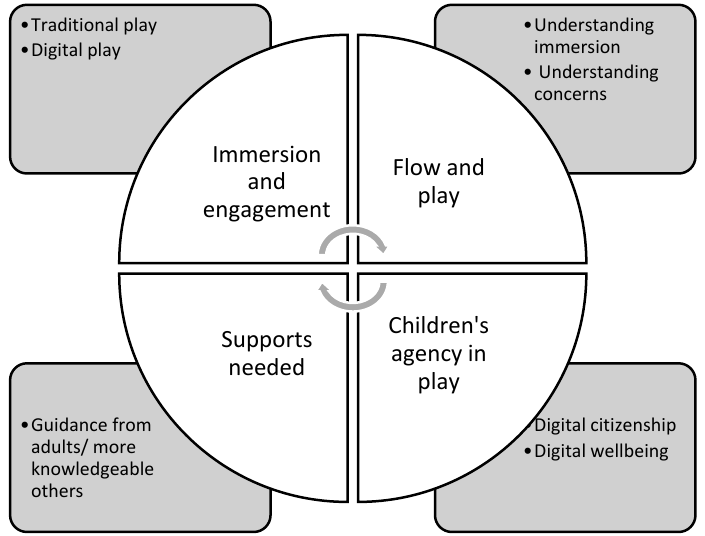
Figure 1. Matrix of key themes relating to digital play and digital wellbeing for young children.